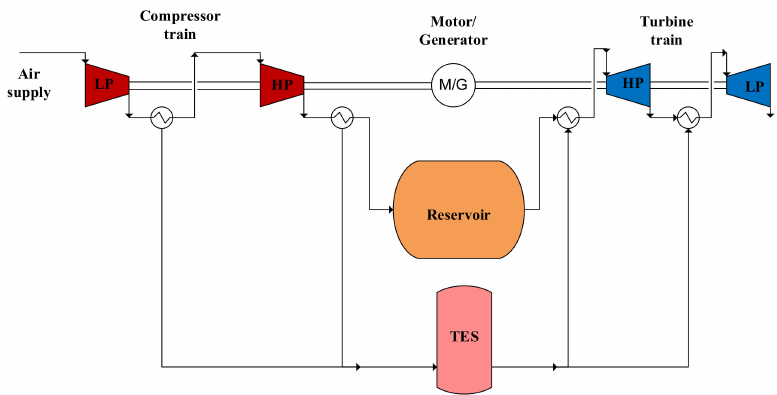
Figure 4. Schematic of AA-CAES with thermal energy storage. Adapted from